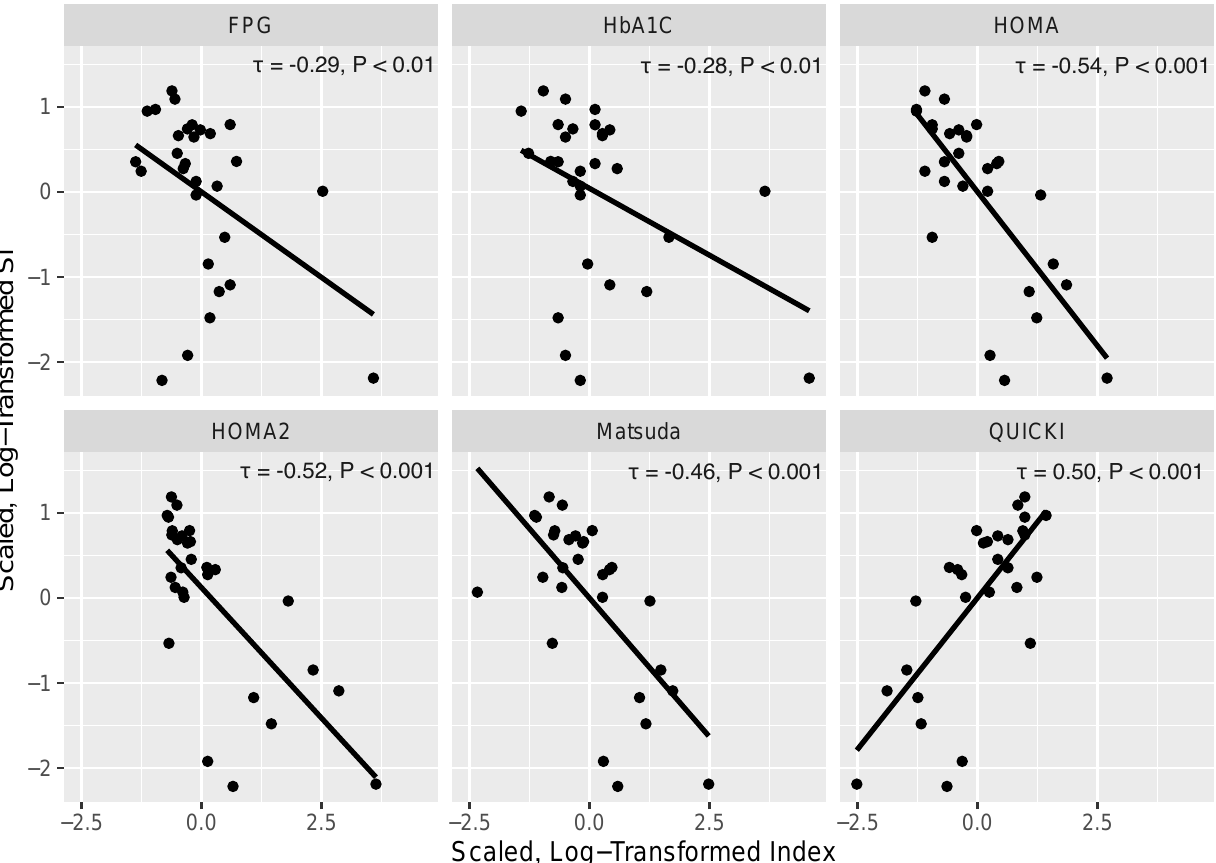
Figure 3. Scatter plots with Kendall rank correlations ( τ ) of the scaled, log-transformed Si, fasting plasma glucose (FPG), hemoglobin A1C (HbA1C), Homeostatic Model Assessment (HOMA) of Insulin Resistance, HOMA2, Matsuda Index, and Quantitative Insulin-sensitivity Check Index (QUICKI)